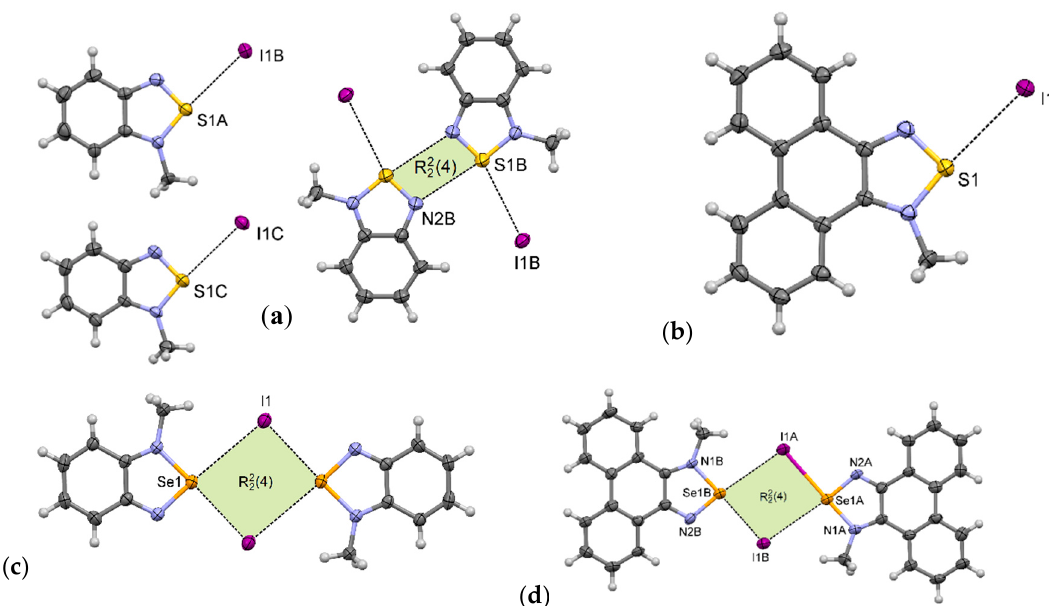
Figure 7. Arrangement of ions in the crystals of: ( a ) 1-MeI , ( b ) 2-MeI , ( c ) 3-MeI , and ( d ) 4-MeI (some hydrogen atoms are omitted for